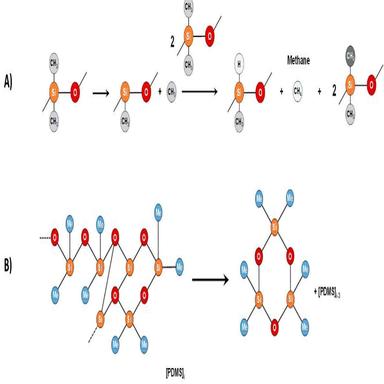
Silicone rubber degradation mechanism: Formation of free radicals (A) and crosslinking (B).